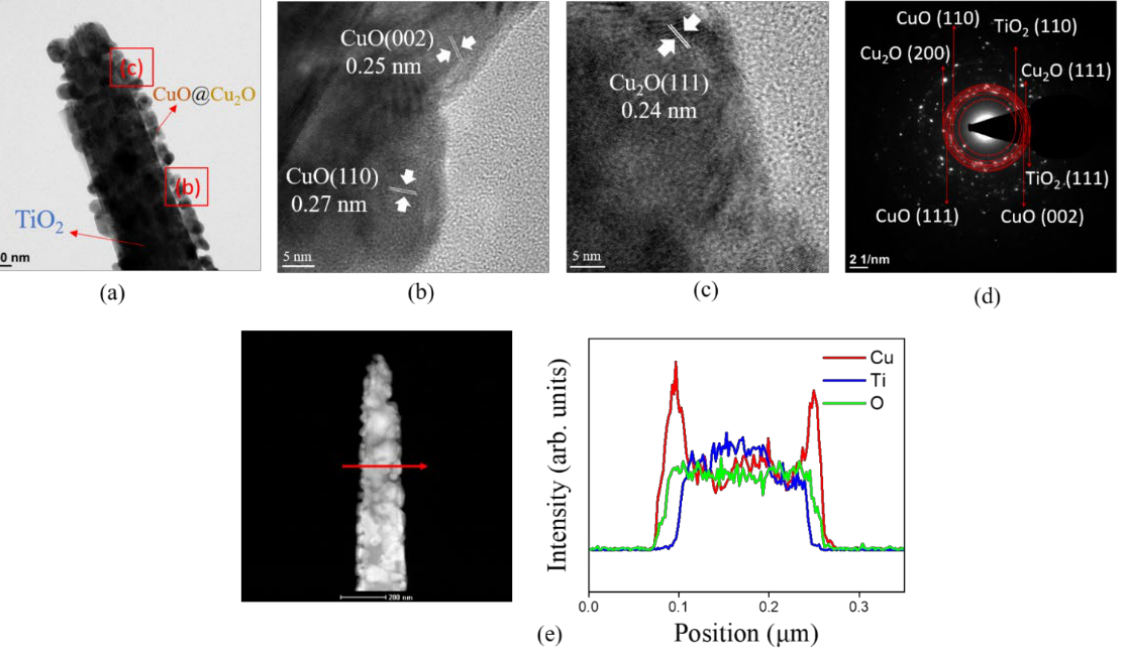
Figure 4. TEM analysis of TC350: ( a ) low-magnification TEM image; ( b , c ) HRTEM images of various regions of the composite rod as marked in ( a ); ( d ) SAED patterns of several TC350 nanorods; ( e ) EDS line scanning profiles across the composite rod.